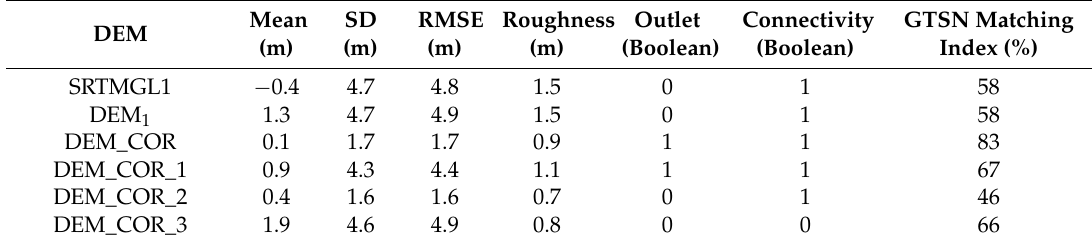
Table 3. DEM vertical accuracy assessment against 10 GCP dataset and river network